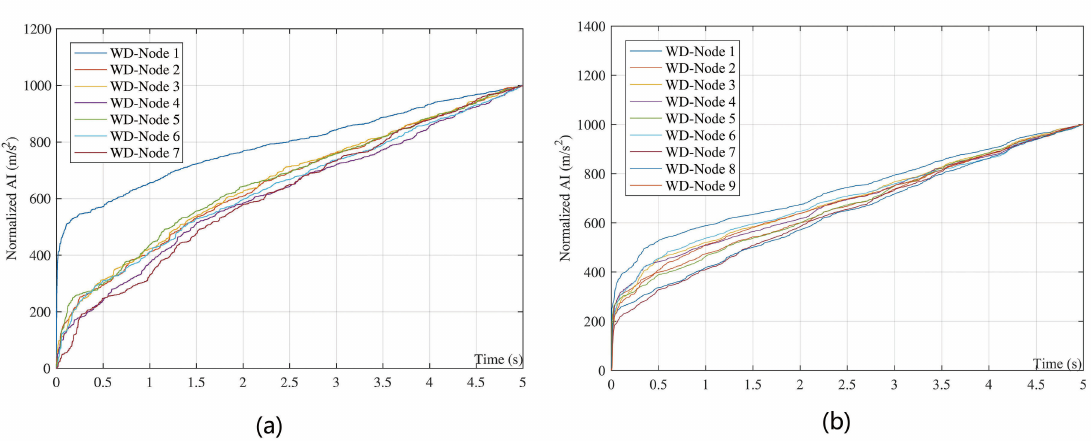
Figure 13. The AIs after normalization for the structure under moving load considering the speed as v = 0.3 m/s. ( a ) Normalized Al calculated for intact bridge and ( b ) normalized AI calculated for the intact